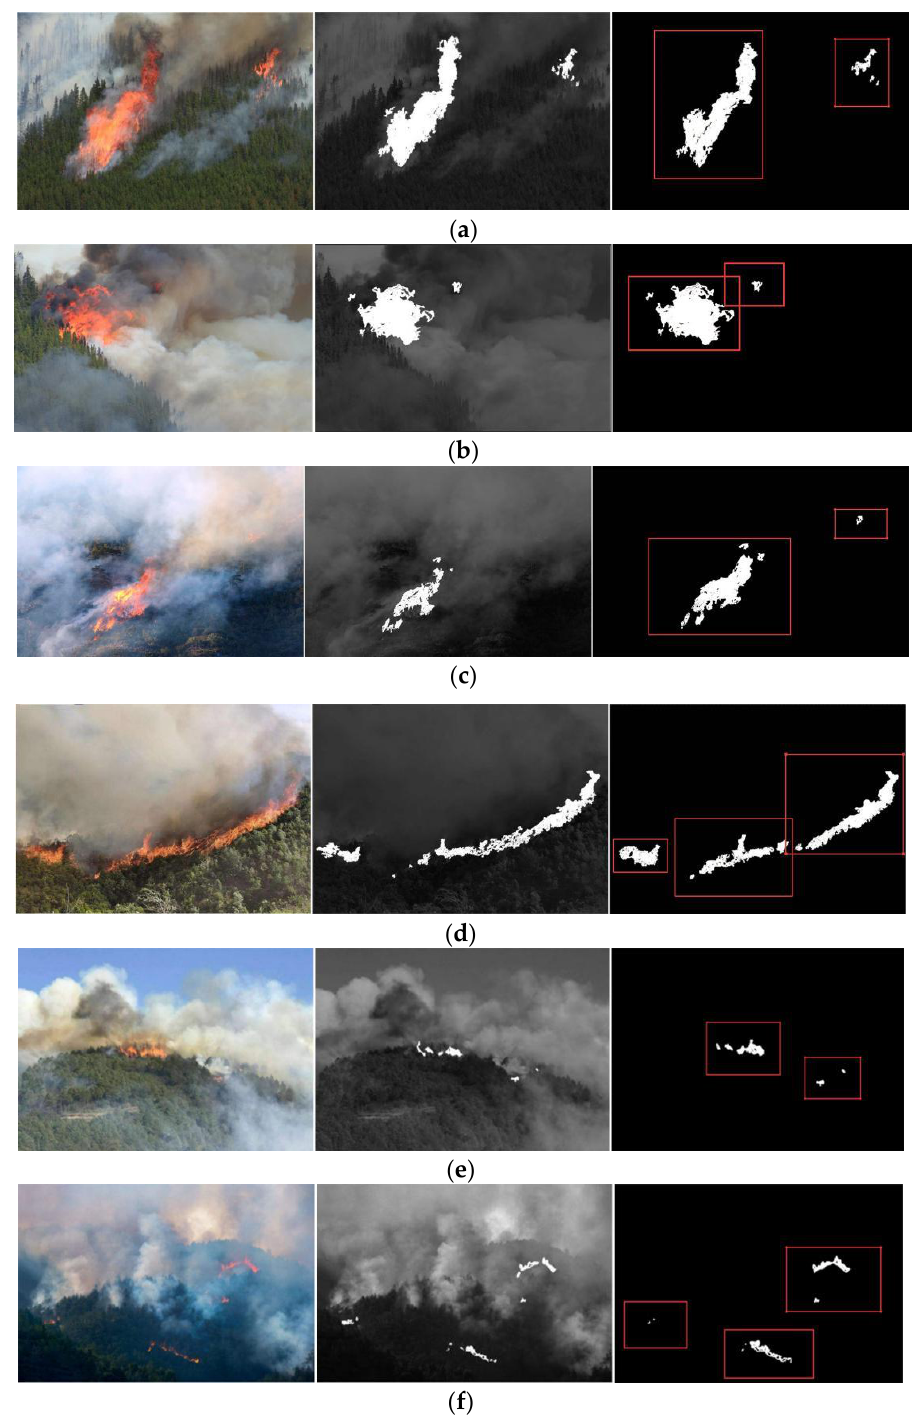
Figure 3. Examples of fire location and segmentation scenes. ( a – f ) Examples 1 – 6.